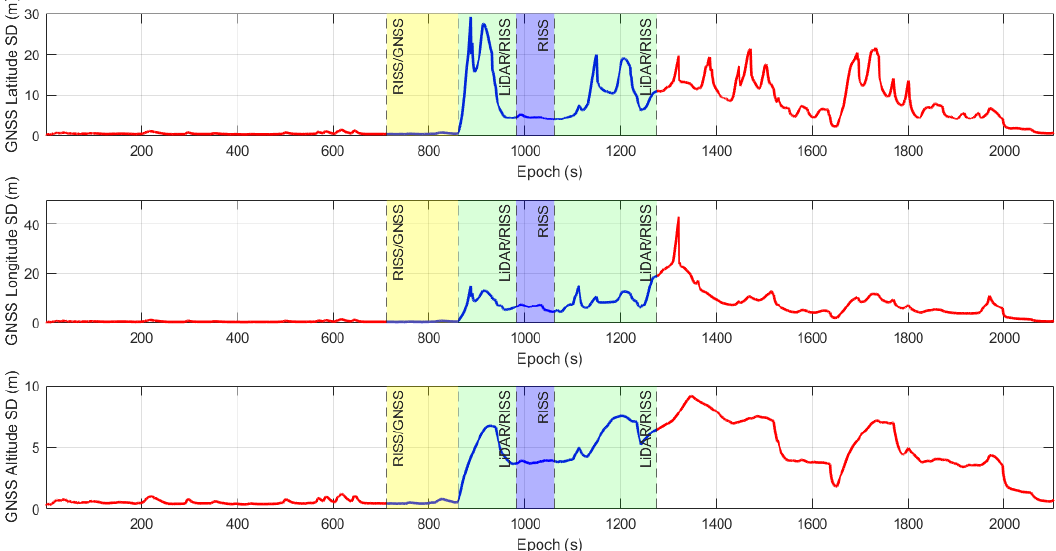
Figure 23. The SD of the 3D-position Provided by the GNSS Before, During, and After the Scenario Highlighting the Switching Between the Systems.